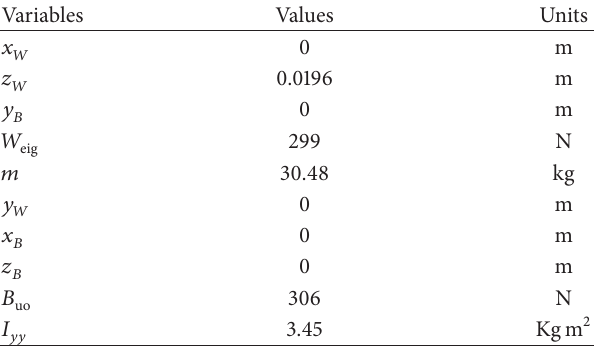
Table 2: Physical parameters of REMUS